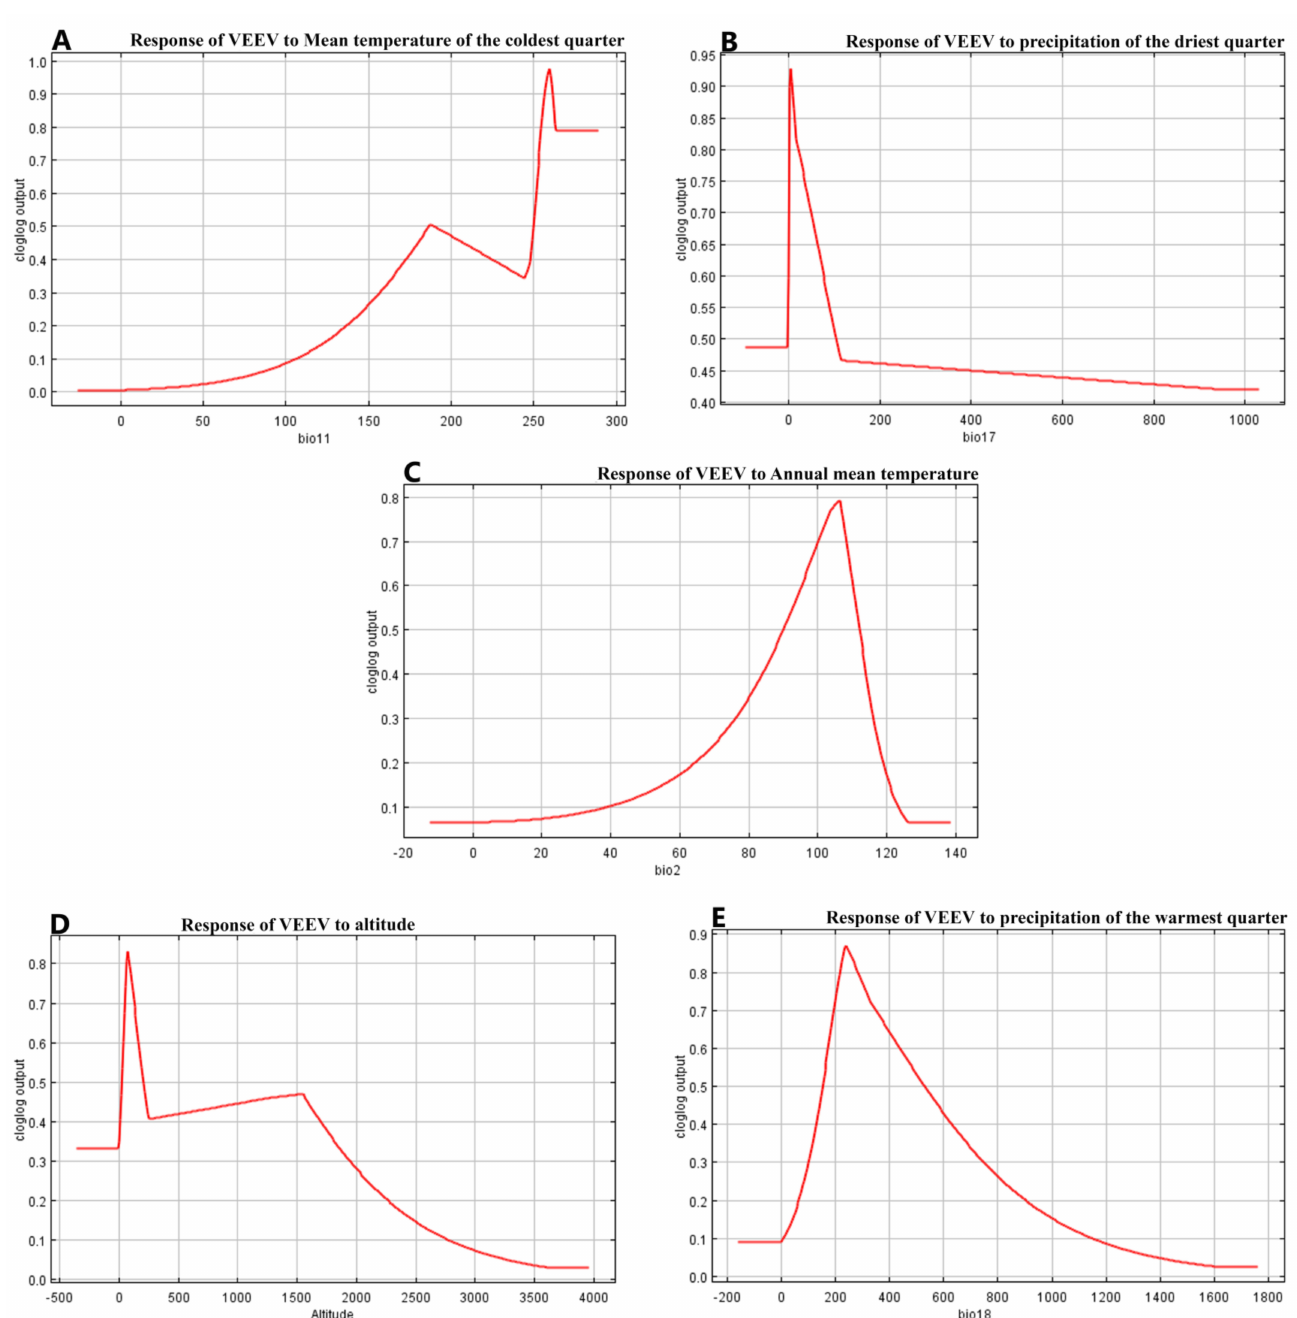
Figure 2. Depicts the effect of each of the variables that contribute the most to the model analyzing each variable by itself without the interaction of other variables. ( A ), Bio11 Mean Temperature of the coldest quarter, the X -axis represents Degrees Celsius by 10, ( B ) Bio17 Precipitation of the driest quarter the units are millimeters of precipitation, ( C ), Bio 2 Annual mean temperature the units are Degrees Celsius by 10, ( D ) X -axis units are millimeters above sea level, and ( E ) units are millimeters of